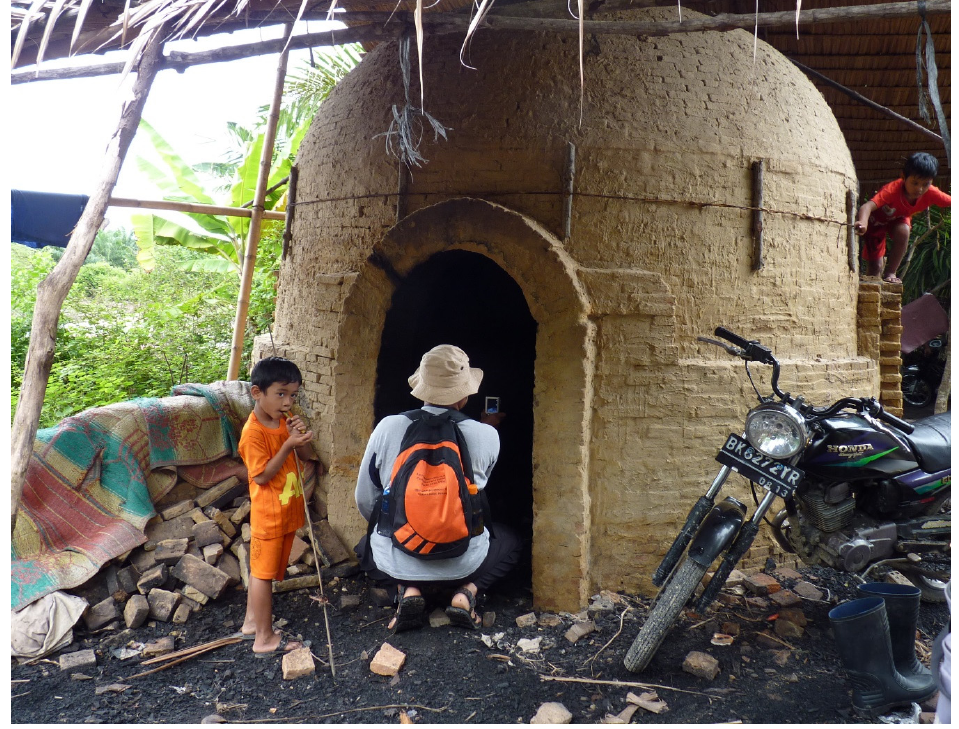
Figure 4. A household charcoal kiln at the edge of a mangrove forest in north Sumatra, Indonesia. Photo by author.